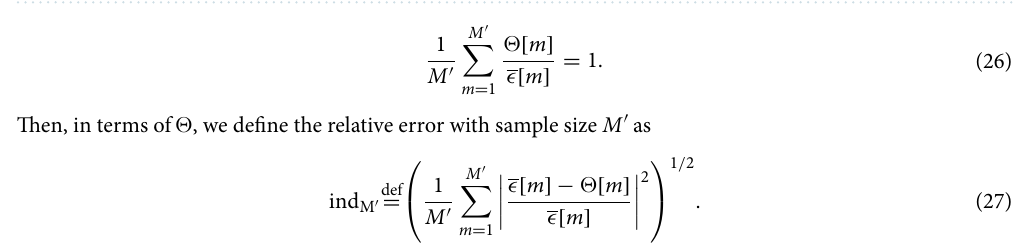
Figure 12. Results of the real data experiment compared with those of the identical twin experiment. Median (horizontal axis) versus confidence interval (vertical axis) of ǫ . ( a ) Results of identical twin experiment. ( b ) Results of real data experiment. For given values of the median on the horizontal axis, the points on the vertical axis indicate the values of the confidence interval (purple segment), arithmetic mean (orange), geometric mean (blue), and energy input rate (black). In b, only 70 confidence intervals out of 353 trials are shown for